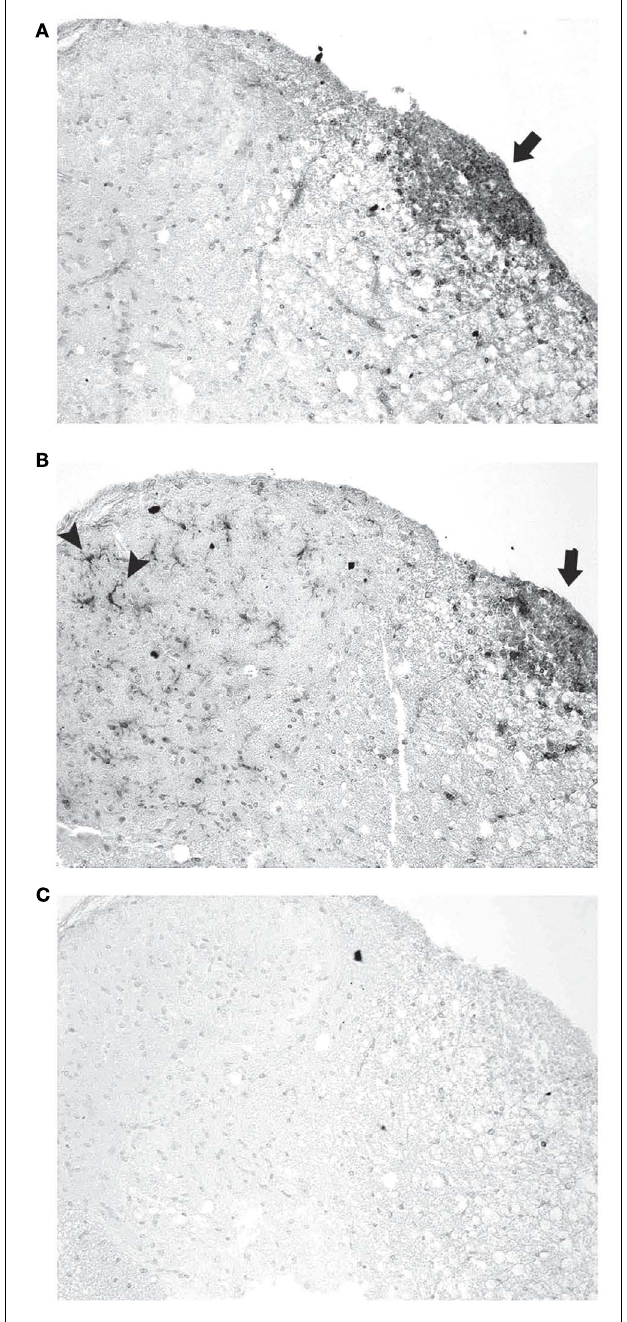
FIGURE 5 | Inflammatory cell types detected in EAE spinal cord. (A) Section of a representative EAE spinal cord 30days post-immunization stained with antibodies to CD3 shows numerousT cells mainly within the white matter (arrow). (B) An adjacent section stained with Iba1 antibodies demonstrates numerous macrophages/microglia in the same inflammatory focus (arrow) in the white matter, as well as individual microglia across the spinal cord white matter and gray matter (arrowheads). (C) Adjacent section stained with B220 antibodies shows B cells do not contribute significantly to observed foci of inflammation. Photos shown at original magnification × 20 (A–C)